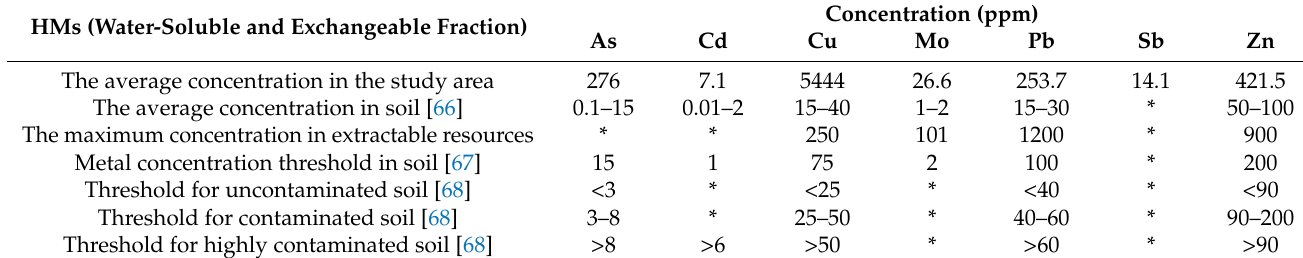
Table 2. The metal content of the soil with world standard limitations (* means not provided).